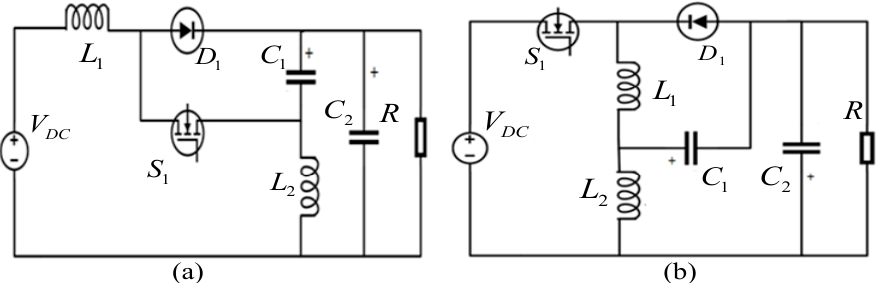
Figure 3. ( a ) Circuit diagram for converter D3 and ( b ) circuit diagram for converter E3 in [26].